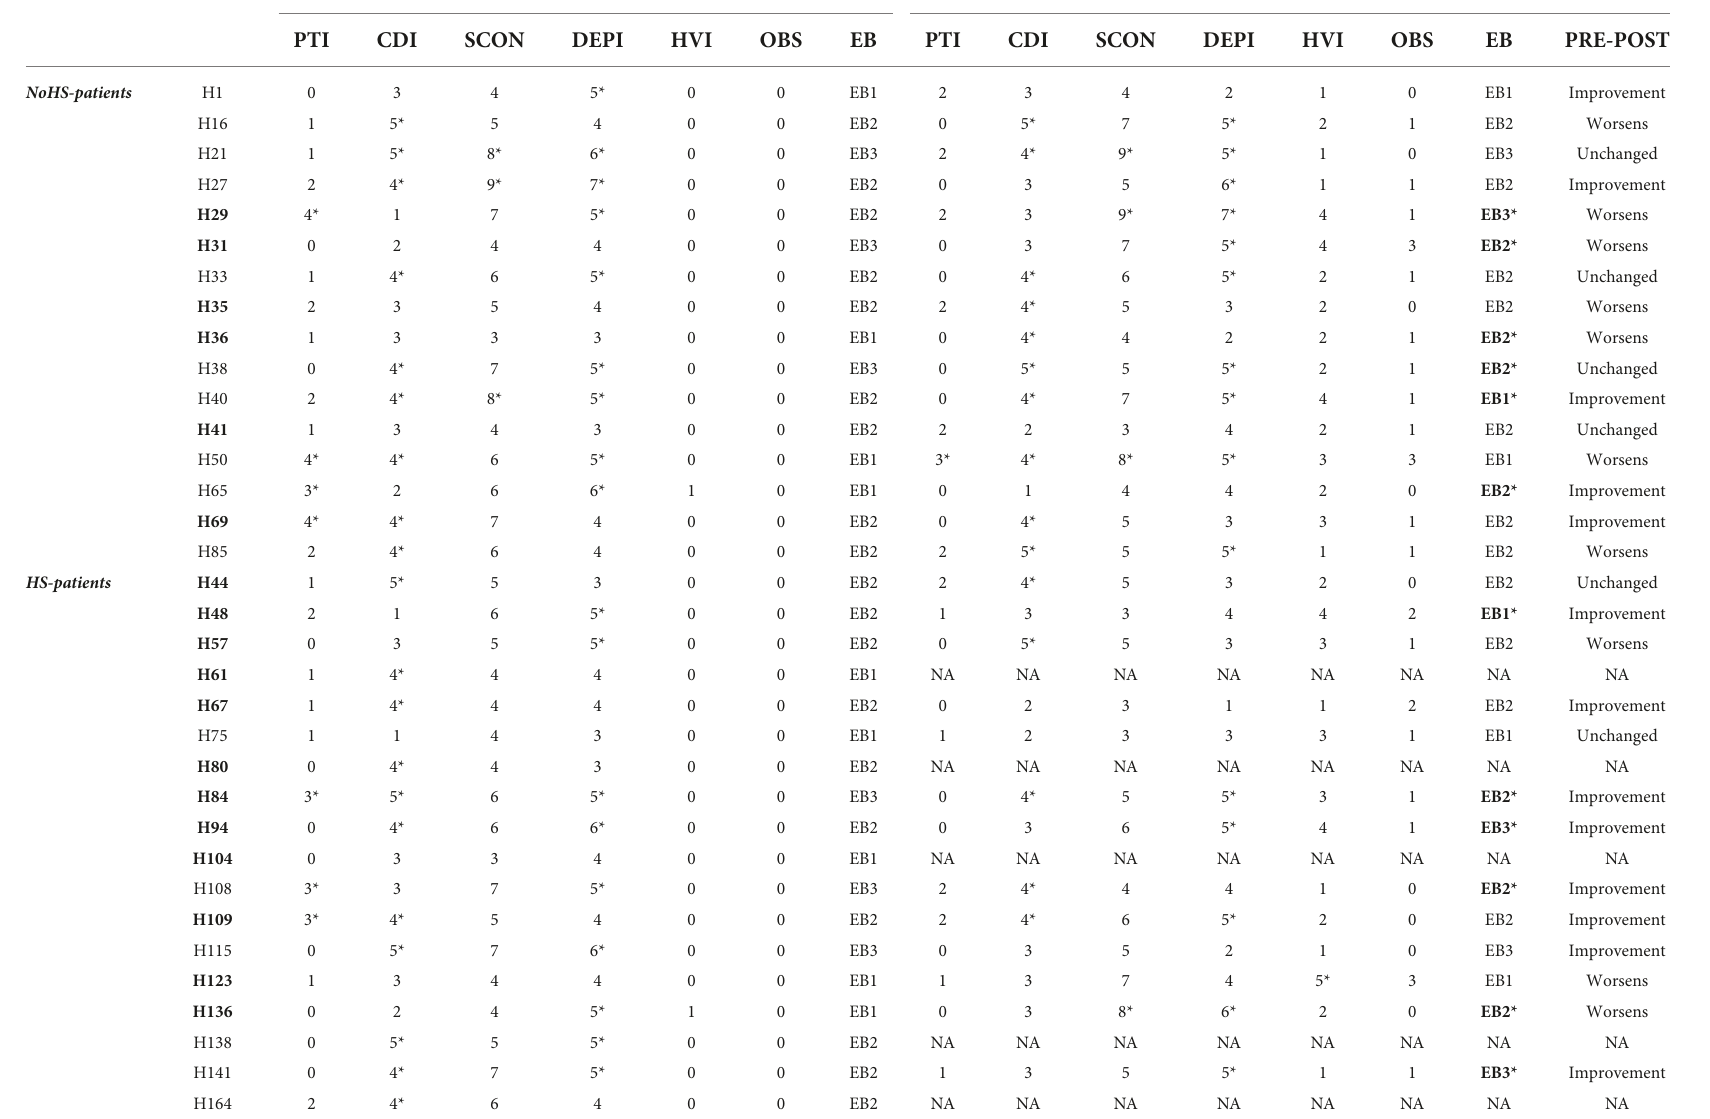
TABLE 7 Summary of Rorschach data of NoHS-patients and HS-patients, before and after surgery. Patient Before surgery After surgery PTI CDI SCON DEPI HVI SCON